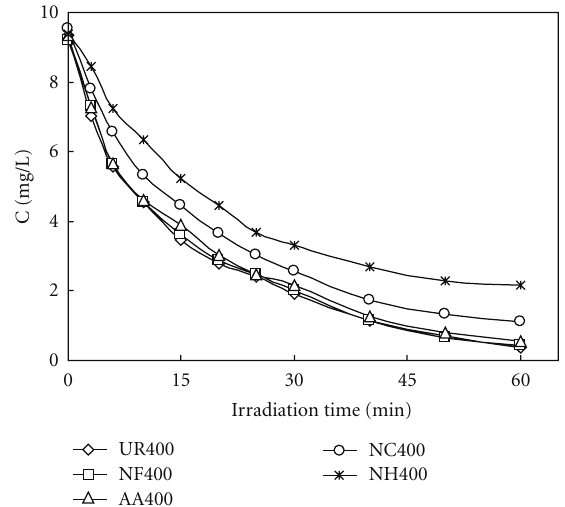
Figure 11: Comparison of photocatalytic activities of NF400, NC400, NH400, UR400, and AA400 under ultraviolet light using p-nitrophenol as model pollutant.